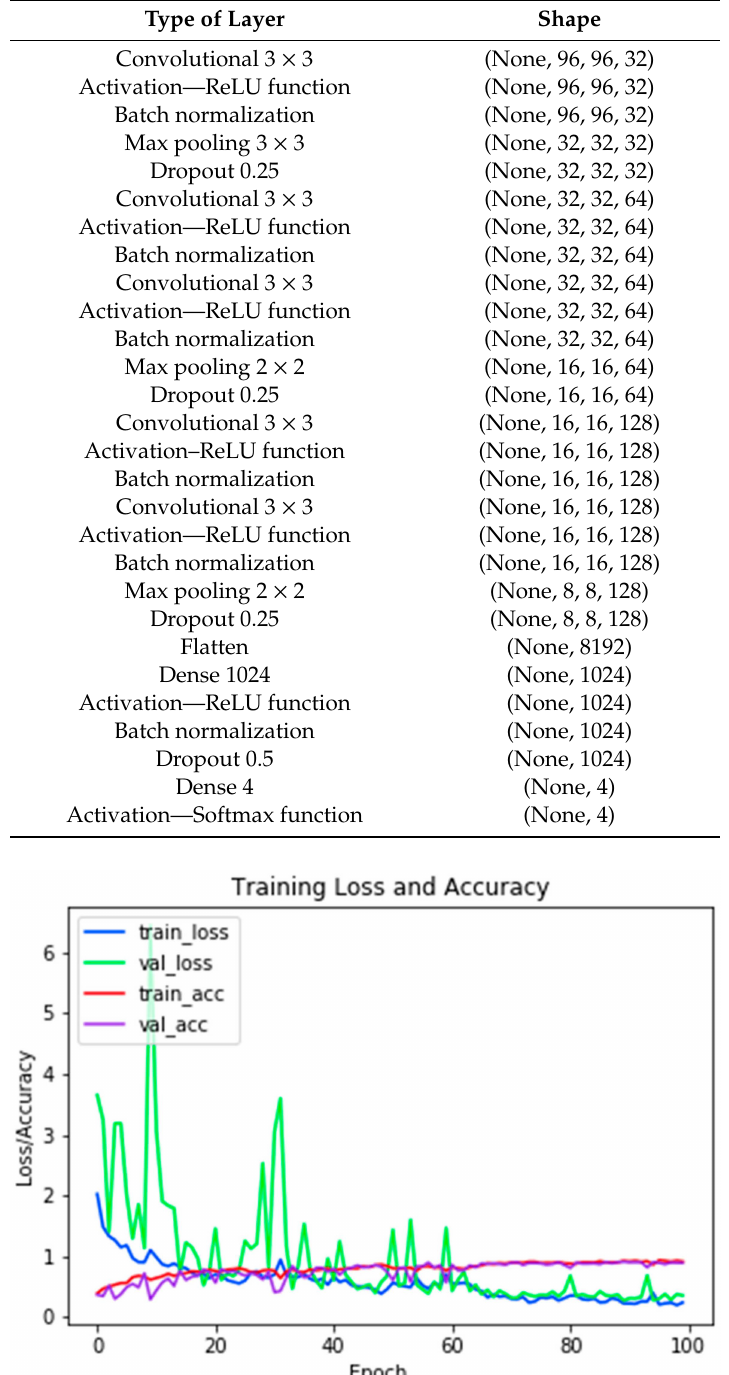
Table 2. Architecture of convolutional neural network.